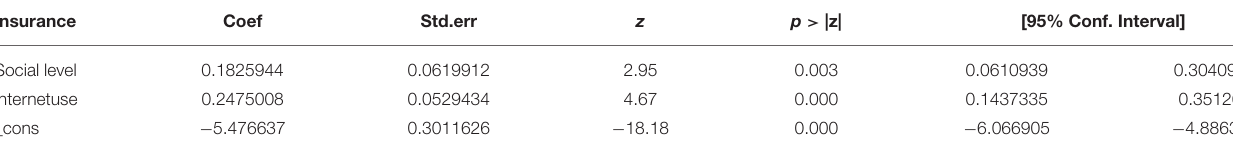
TABLE 8 | Total effect.